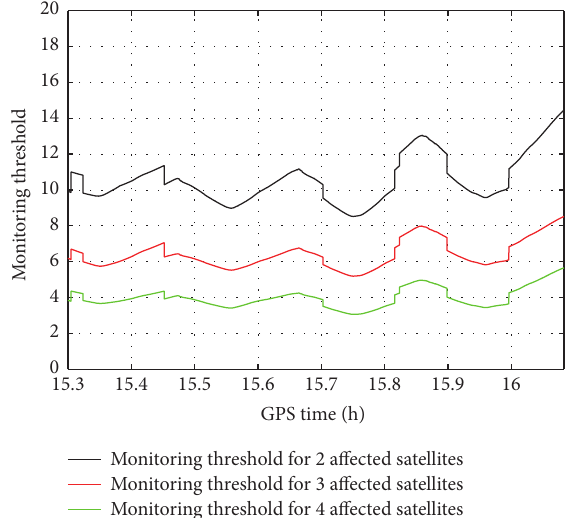
Figure 9: Monitoring thresholds assuming two full dual frequency capable constellations and 2, 3, and 4 simultaneously affected satel- lites.